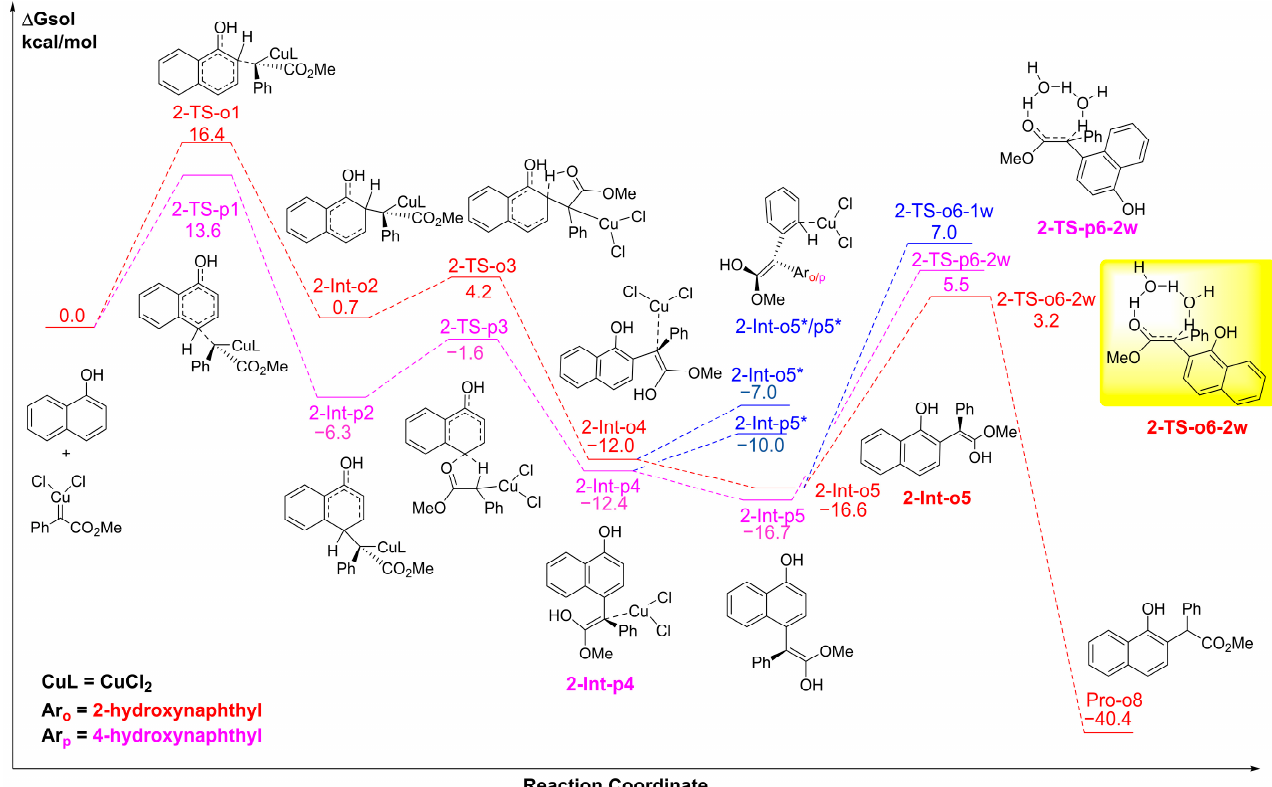
Figure 5. The calculated free energy profiles Δ G sol and the corresponding structures of intermediates and transition states along different pathways of the C–H bonds of naphthols inserted by the monometallic carbenes of CuCl 2 . The reasonable ortho-selective pathway is shown in red, the para-selective pathway is pink, and other possible pathways are in blue. The free energies are given in kcal mol − 1